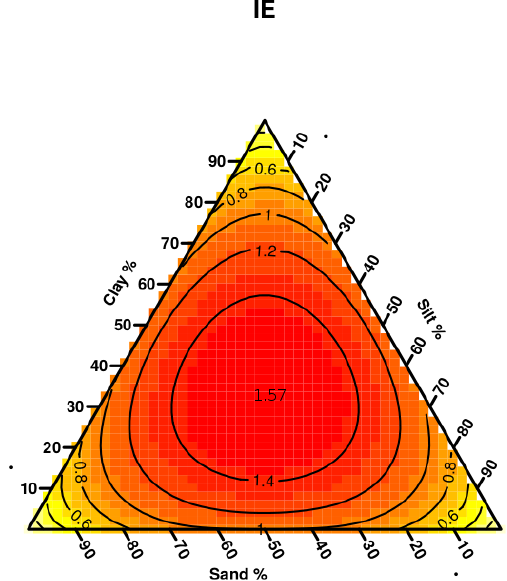
Figure 1. IE numerical approximation ternary representation: IE is computed for a sample of 5051 evenly distributed soils in the USDA textural triangle using the clay, silt, and sand fractions as input triplet. This distribution of IE is repeated for any textural tri- angle, when the fractions used for its calculations are the ones at the axes of the triangle. The lowest values for the IE are near the vertex of the triangle, i.e. where one fraction dominates above the others. Biggest values are located towards the centre of the triangle, where the distribution fractions are more